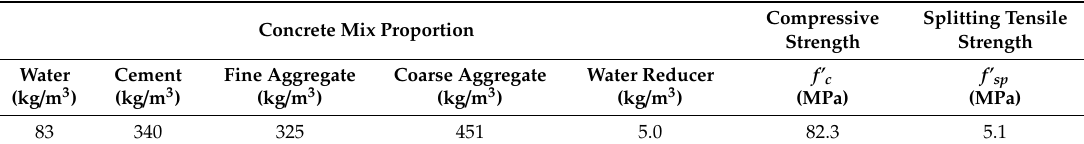
Table 2. Mix proportion and measured strength values for the substrate concrete. Concrete Mix Proportion